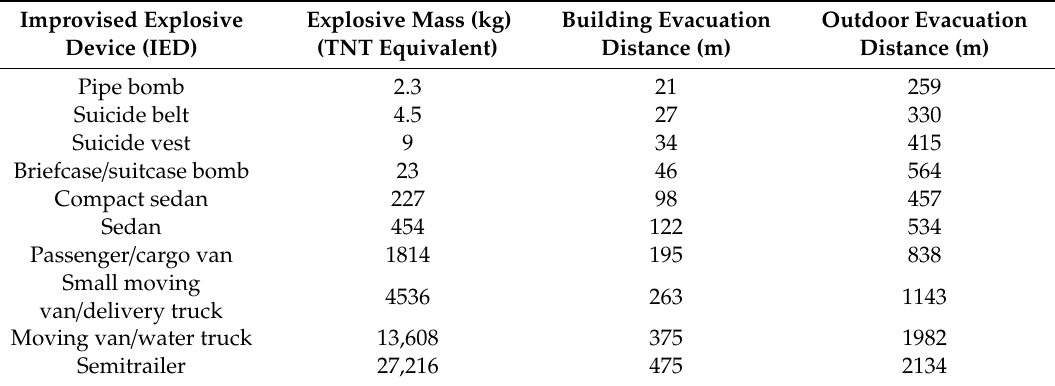
Table 1. Improvised explosive device (IED) standoff distance chart.